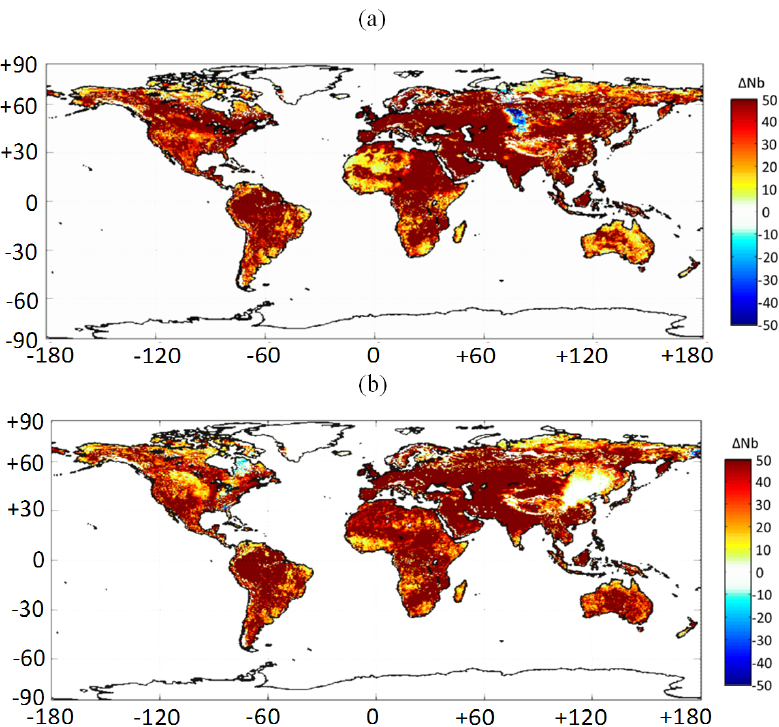
Figure 9. Global map of the difference in the mean number of SM successful retrievals per year over the 2011–2015 period (L3SM MO – L2SM SO ) for ascending orbits (a) and descending orbits (b)